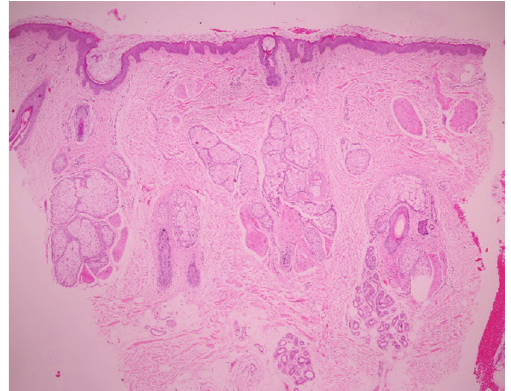
Figure4:Histopathologyshowedincreasednumbersofcatagenand telogen hairs, without perifollicular infiltration (hematoxylin and eosin staining; 20x).